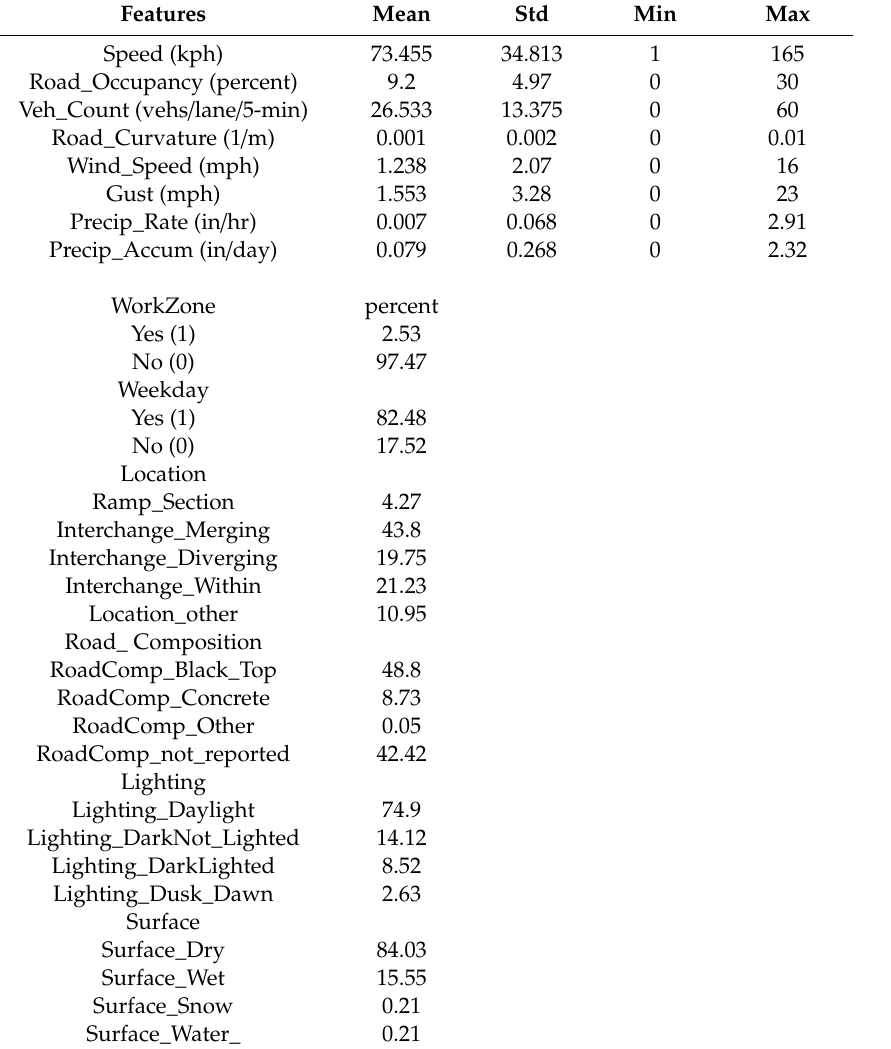
Table 3. Data description for RTWE features.